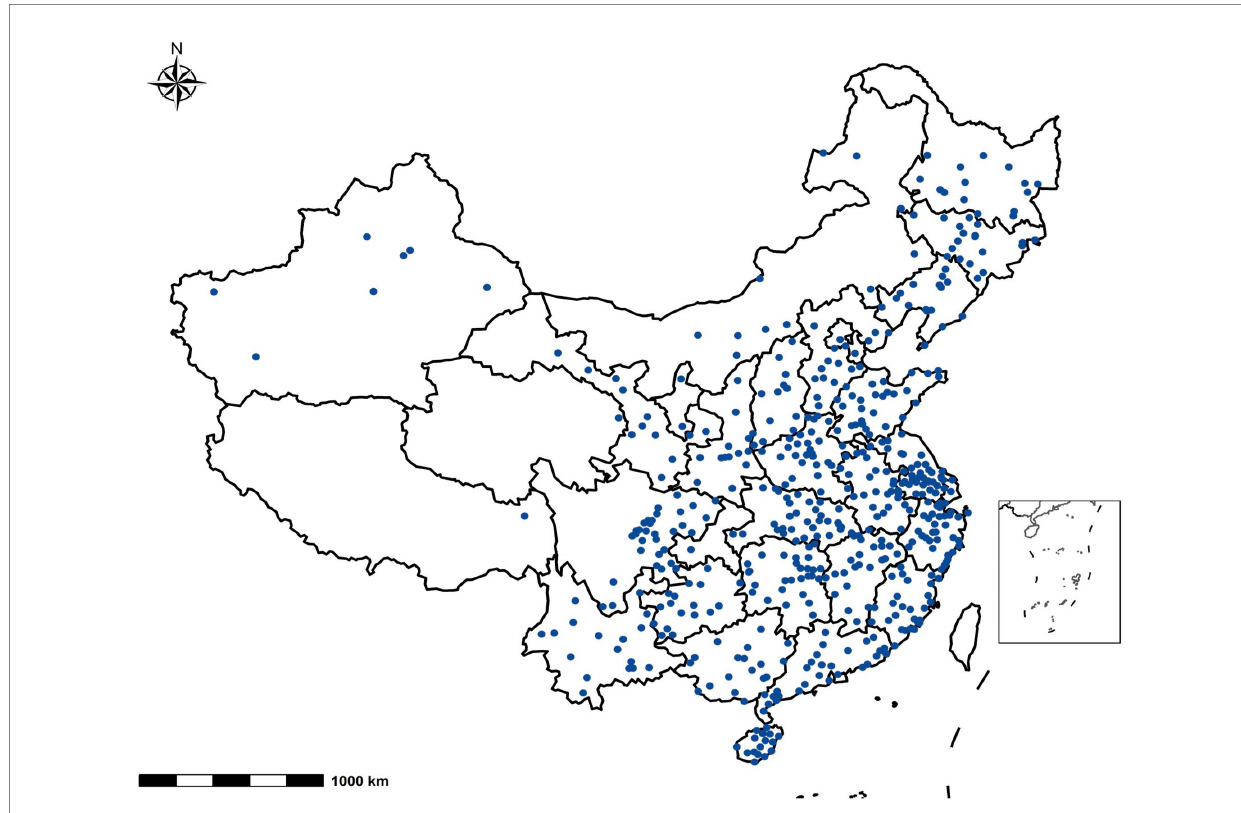
FIGURE 2 Distribution of 551 participant cities from 31 provinces/municipalities/autonomous regions in mainland China.